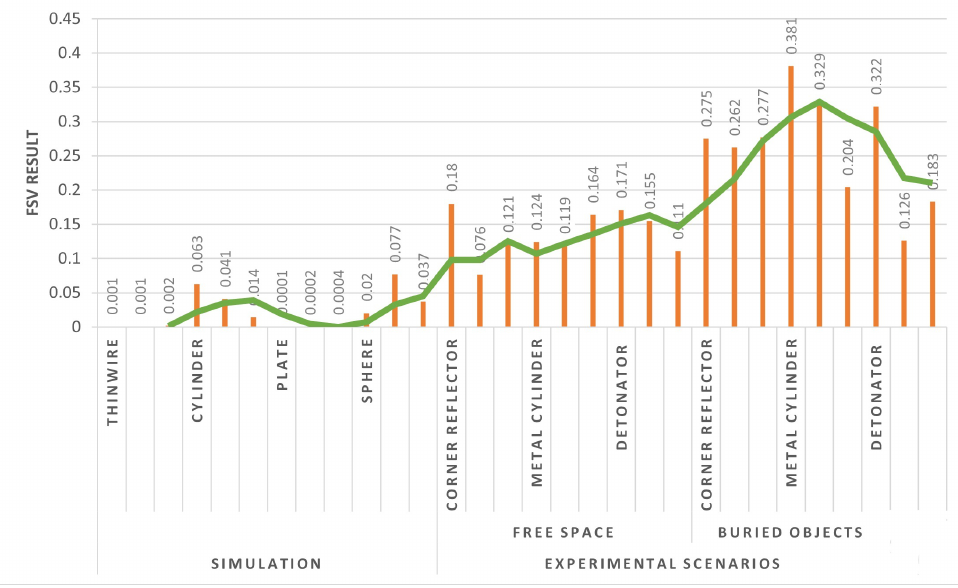
Figure 15. FSV result for all backscattering scenarios arranged according to increasing signal noise. The green line corresponds to a moving average and is higher for buried objects